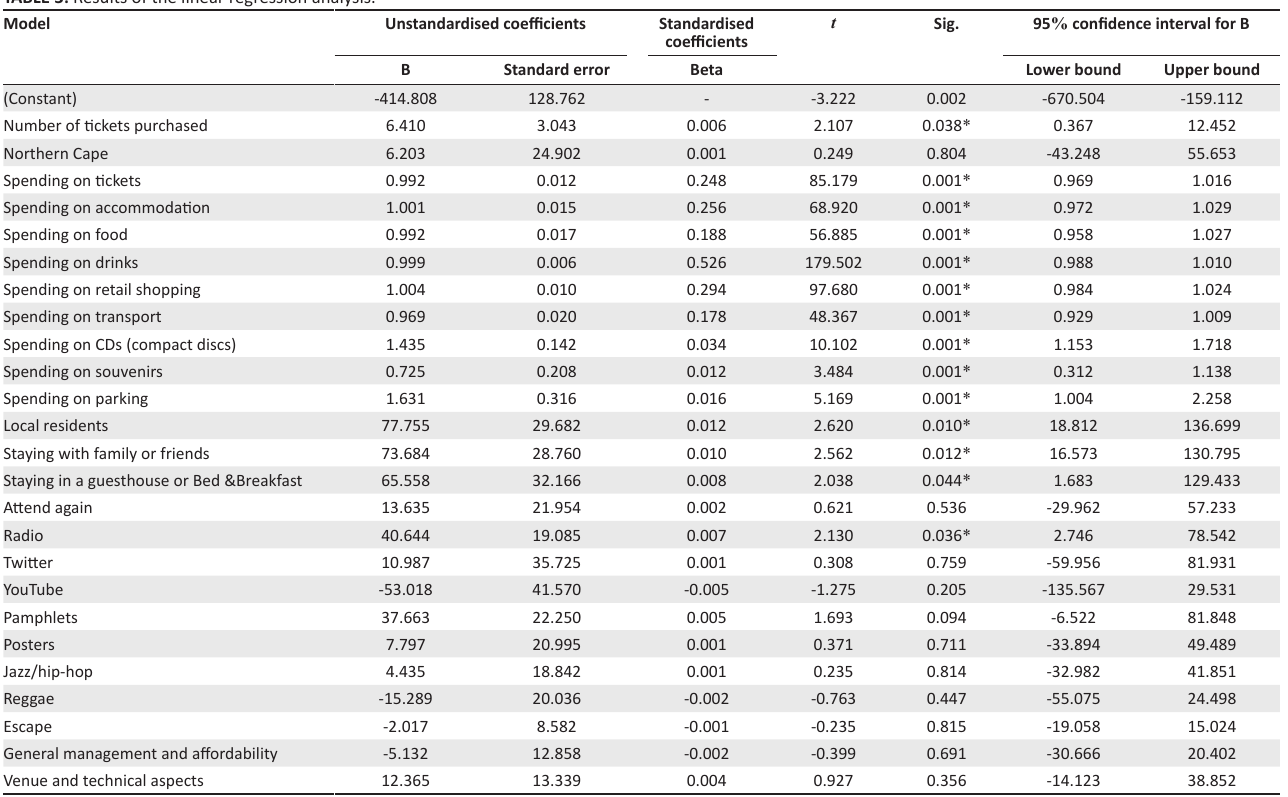
TABLE 3: Results of the linear regression analysis.